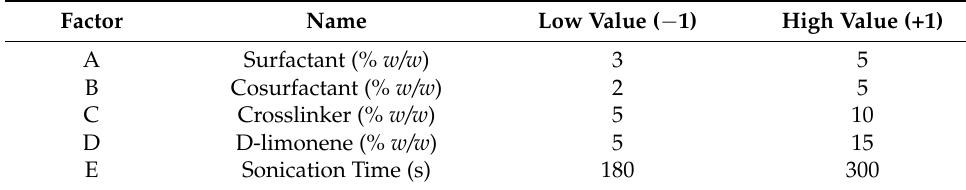
Table 1. The two-level values of the variables for the respective studied